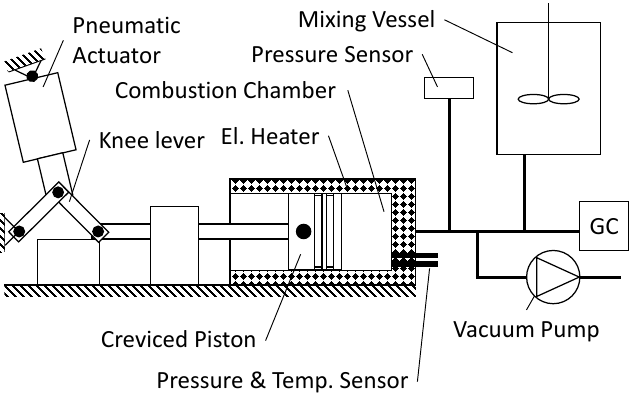
Figure 1. Schematic of the main components of the RCM experiment. Adapted from